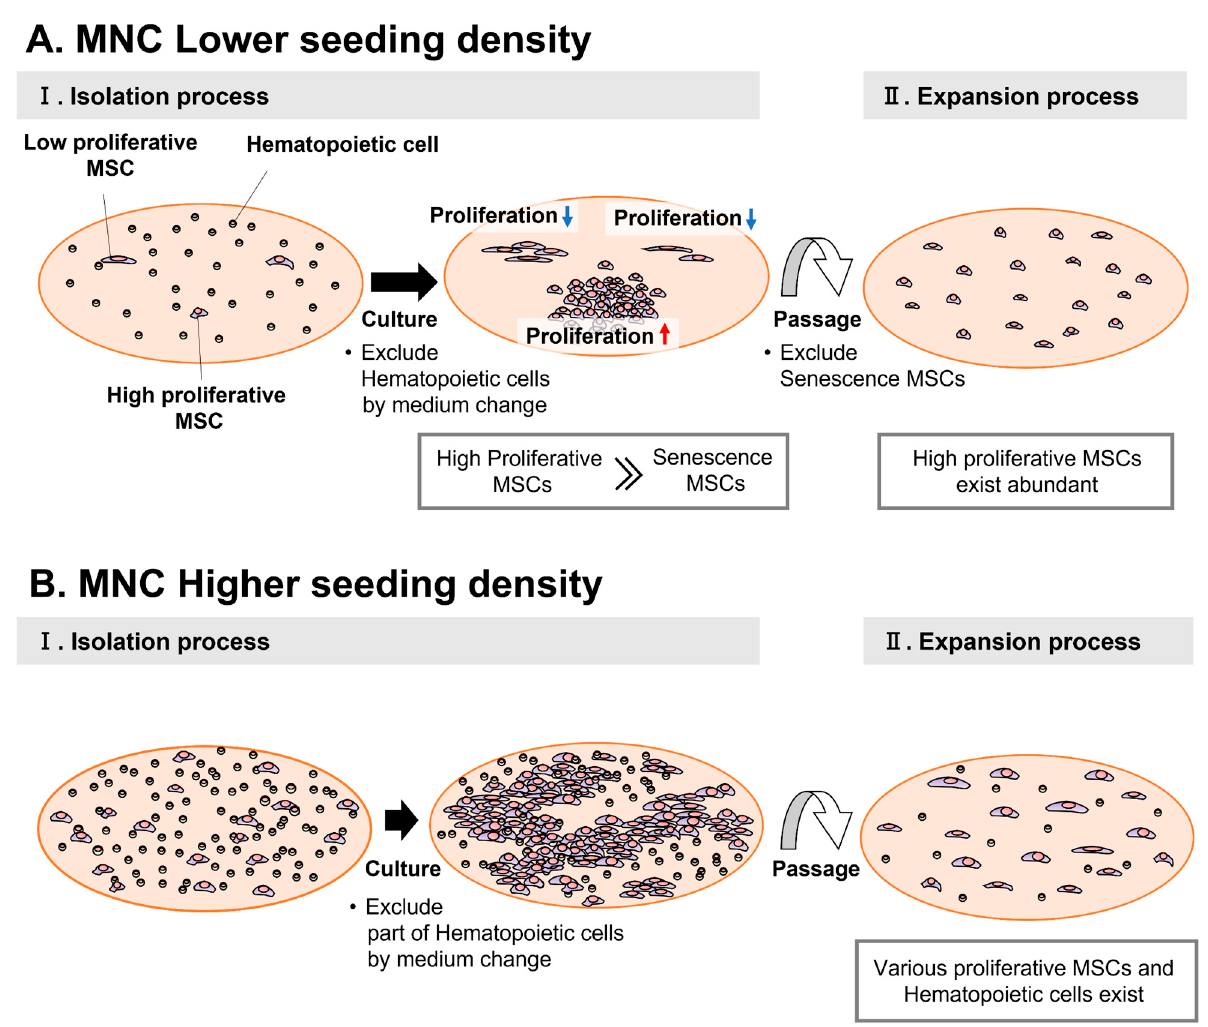
Figure 7. Overview of mesenchymal stem cell (MSC) colony formation at different mononuclear cell (MNC) seeding densities. ( A ) Colony-formation process under conditions of low seeding density (4.0 × 10 4 and 1.25 × 10 5 cells/cm 2 ). ( B ) Colony-formation process under high seeding density conditions (6.3 × 10 5 and 1.25 × 10 6 cells/cm 2 ).